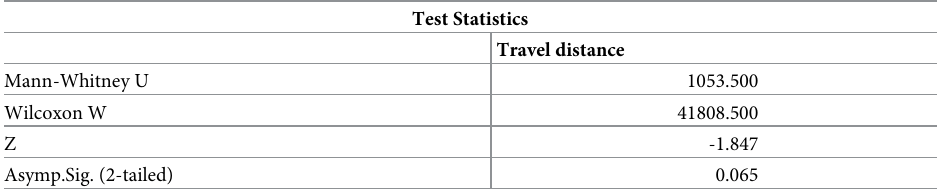
Table 9. Mann-Whitney U test statistics—Travel distance by respondents.